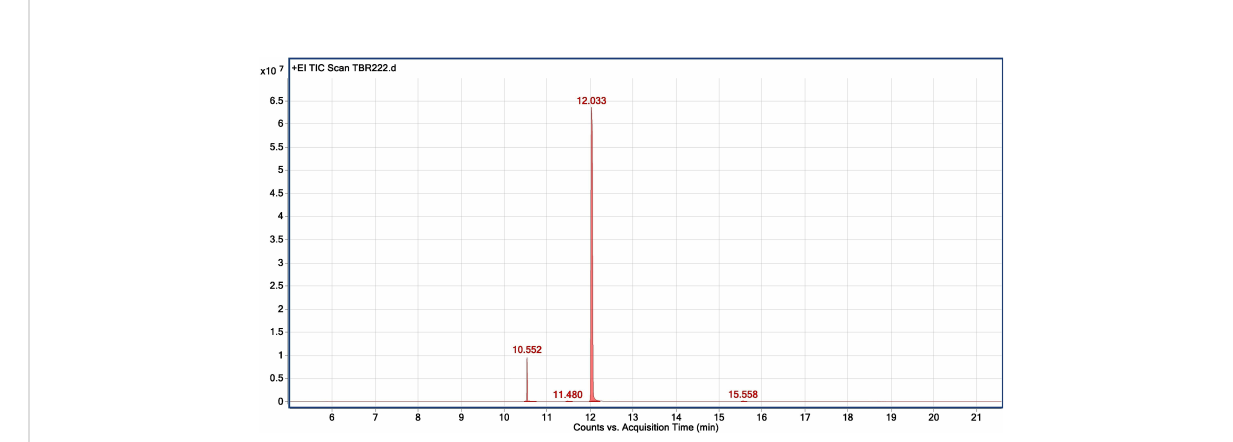
FIGURE 7 Chromatogram for GC-MS analysis of anethole rich variety Jor Lab CH-2 of Clausena heptaphylla